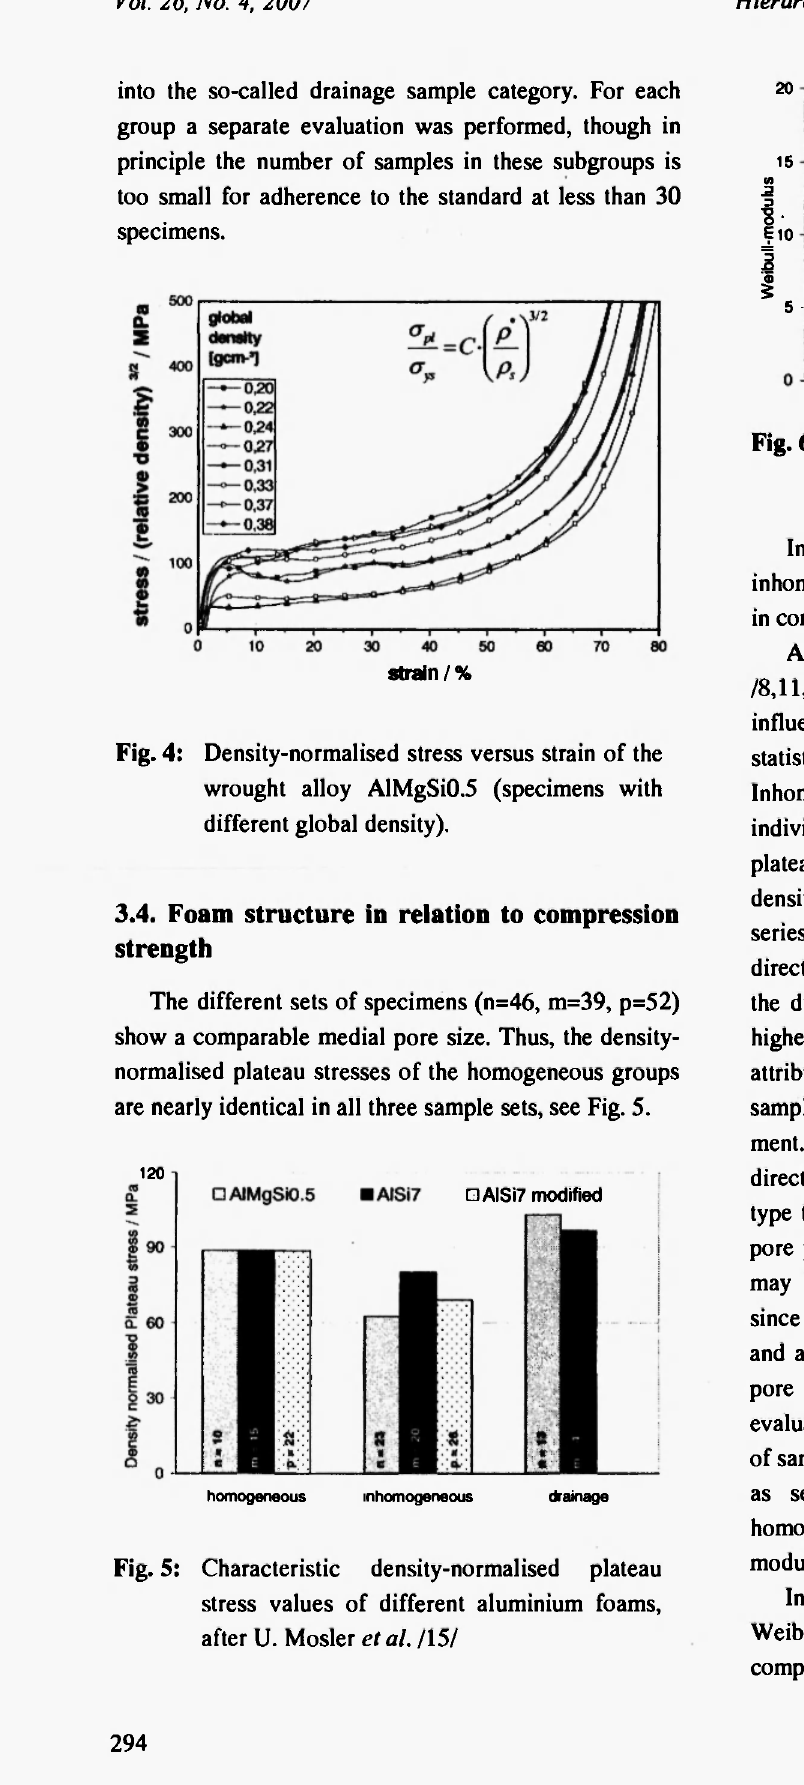
Fig. 6: Evaluated of different aluminium foams, after U. Mosler et al.